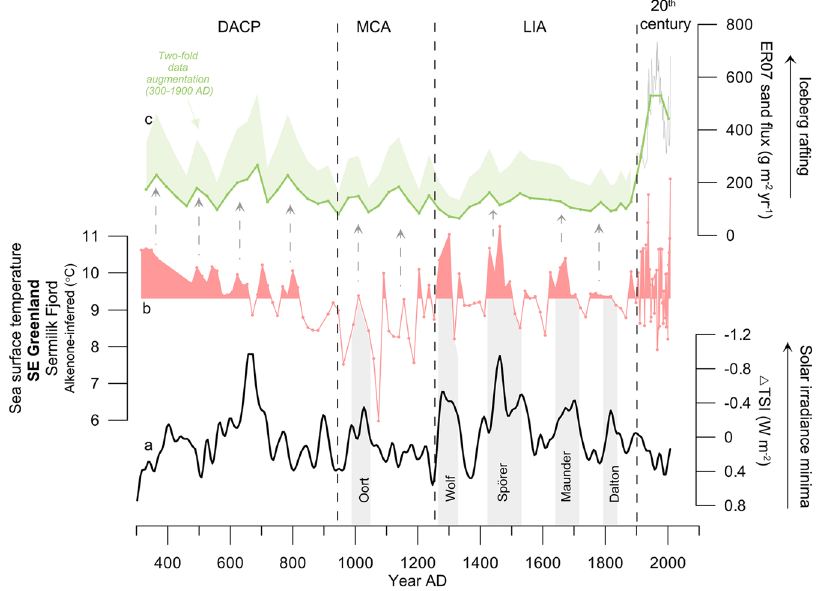
Figure 3. Core ER07 data from Sermilik Fjord and solar activity. ( a ) Solar irradiance reconstruction 60 . ( b ) SST reconstruction from core ER07 in Sermilik Fjord, SE Greenland based on alkenone thermometry (this study). ( c ) Green line: sand flux in core ER07 used as a proxy for relative iceberg rafting (green shading: reconstruction augmented 300–1900 AD). In order to compare the lower and higher resolution portions of the IRD record, a 32 years binning was applied in data younger than 1900 AD (32 year is the average time resolution of samples older than 1900 AD). The original raw data are shown as a thin grey line. Grey stippled arrows indicate concurrent ER07 SST and ice rafting peaks. Grey bars indicate periods when increased SST concurs with low solar